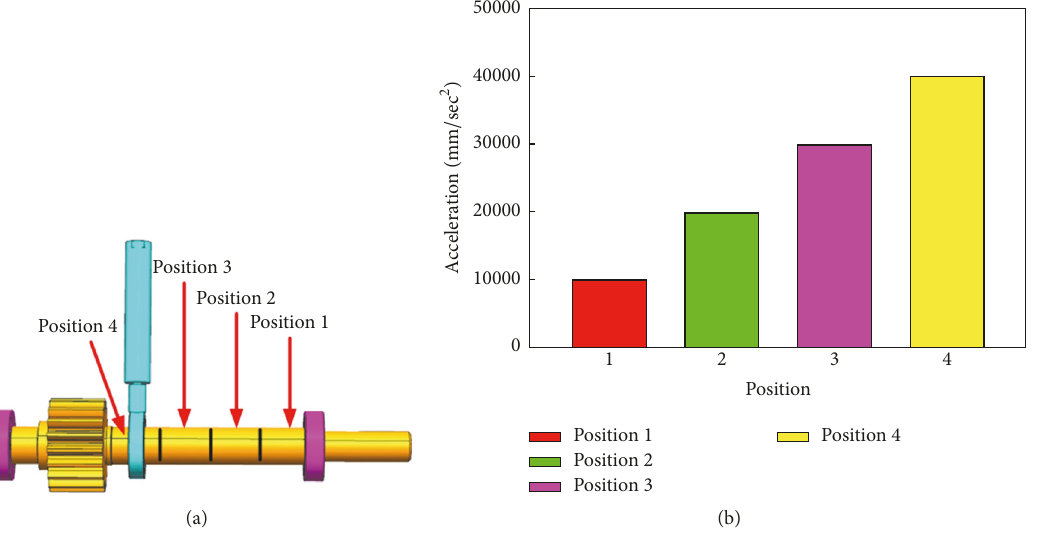
Figure 8: The diagrammatic sketch of the actuating position for PZTs and the vibration magnitudes at the corresponding position.